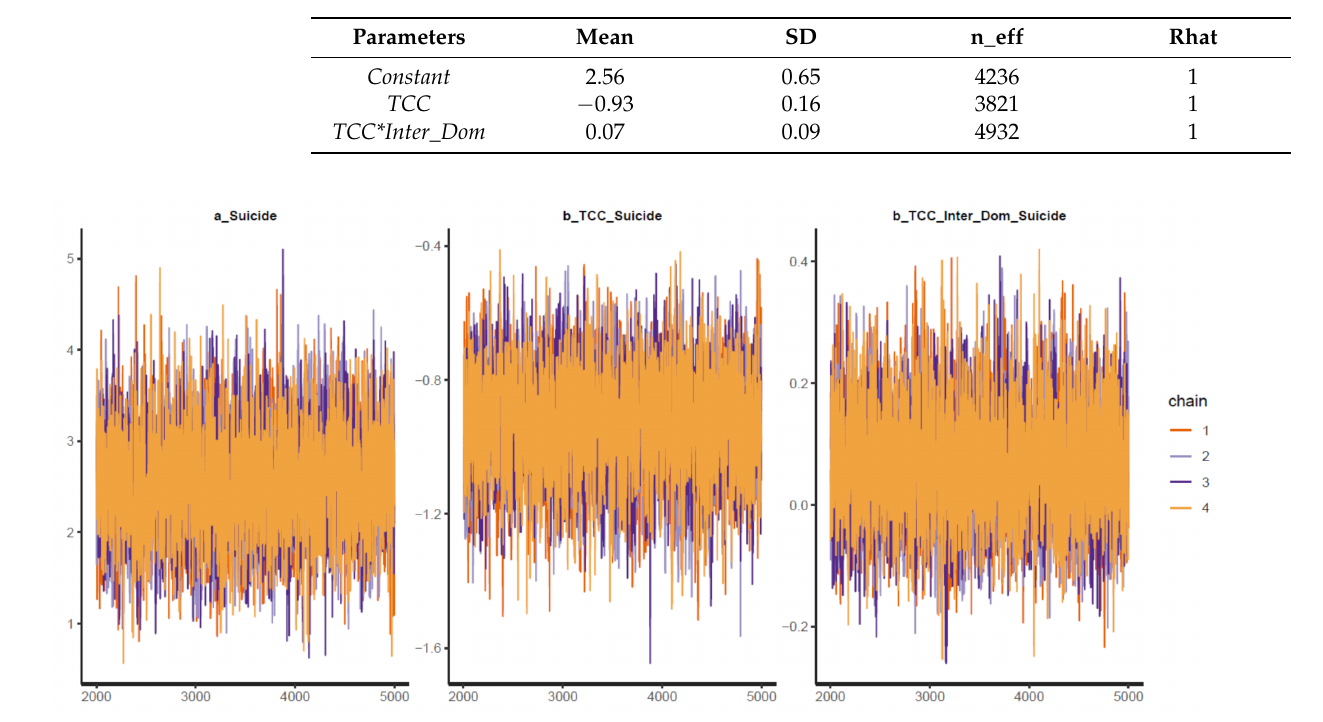
Table 2. Model 1 (cid:48) s simulated posteriors.